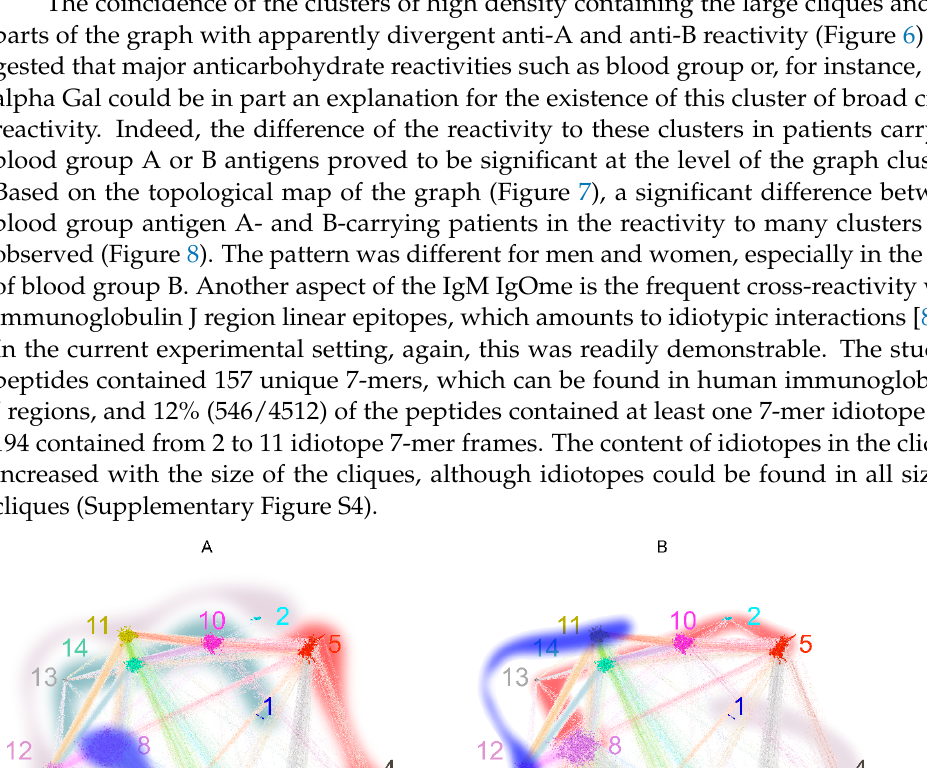
Figure 9. Viral epitopes are an important organizing element of the IgOme. ( A ) Distribution of viral epitopes as a function of clique size. They are very common in the overlapping large cliques without being over-represented in the set of peptides that are found in large cliques. This suggests that they are central elements on which many large cliques overlap. Viral epitopes are also found mostly in cliques with a lower capacity to classify the tumor patients (blue and red lines). ( B ) Viral epitope (probably preimmune) reactivities are found in many large cliques of the reactivity graph because they are most often the ones in which the large cliques overlap. Omitting them leads to a graph with significantly fewer large cliques (red line) compared to the bootstrapped-induced subgraphs lacking the same number of randomly sampled vertices. Interestingly, the most prominent viral specificities were several HTLV1 epitopes (Supplementary Figure S6). The latter is probably cross reactivity with unknown